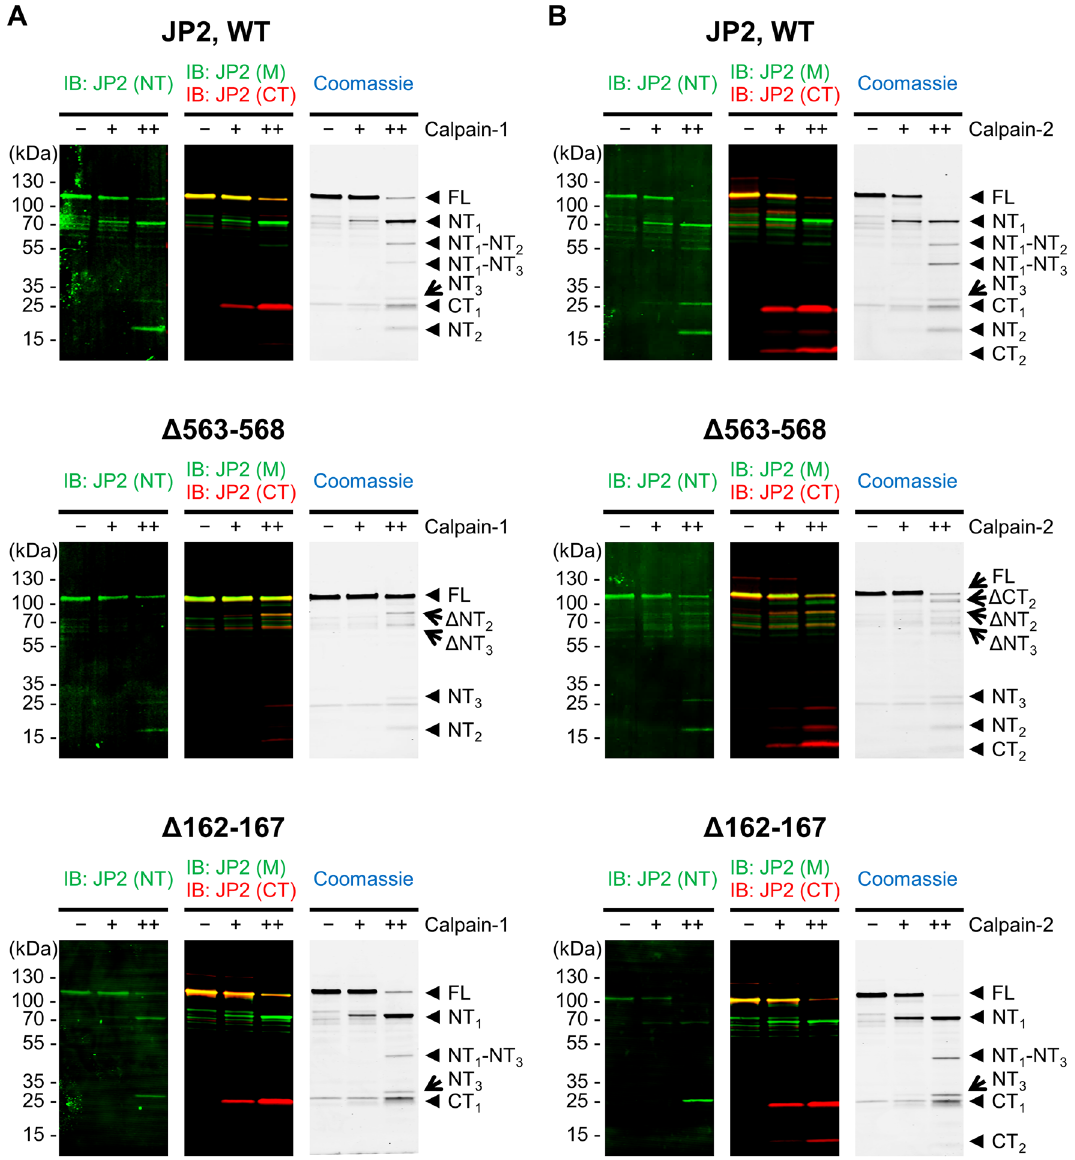
Figure 2. Proof-of-concept study of the primary and secondary Calpain-1 and Calpain-2 cleavage sites R565 and S164, respectively. Mouse JP2 WT versus the site-specific deletion mutants JP2 Δ563-568 or JP2 Δ162-167 were digested with 0.01 U/ml (+) or 0.10 U/ml (++) Calpain-1 ( A ) and Calpain-2 ( B ) for 30 min at 30 °C, and subjected to SDS-PAGE. The Calpain-specific cleavage patterns were detected by Coomassie staining and immunoblotting based on JP2 antibodies against the N-terminal (NT), middle (M) and C-terminal region (CT) indicated in Fig. 1A. Compared to WT (top), the JP2 deletion mutation Δ563-568 (middle) significantly changes the cleavage pattern by preventing the primary cleavage event. Importantly, the NT 1 and CT 1 fragments are not generated following Calpain-1 or Calpain-2 treatment of the JP2 Δ563-568 deletion substrate. Additionally, the JP2 deletion mutation Δ162-167 (bottom) prevented the secondary cleavage event and the generation of the Calpain-1 and Calpain-2 specific NT 1 -NT 2 and NT 2